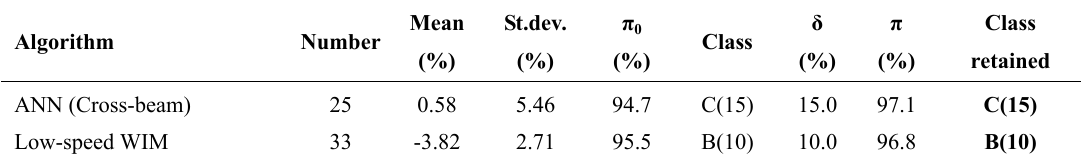
Table 6. Accuracy results of GVW from B-WIM and Low-speed WIM (Seohae